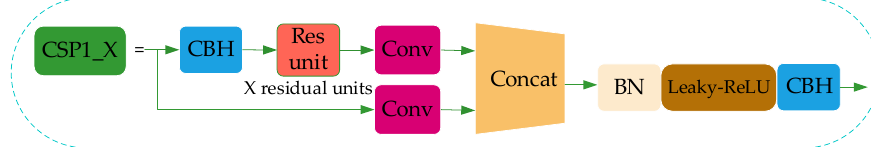
Figure 4. CSP1_X module structure.